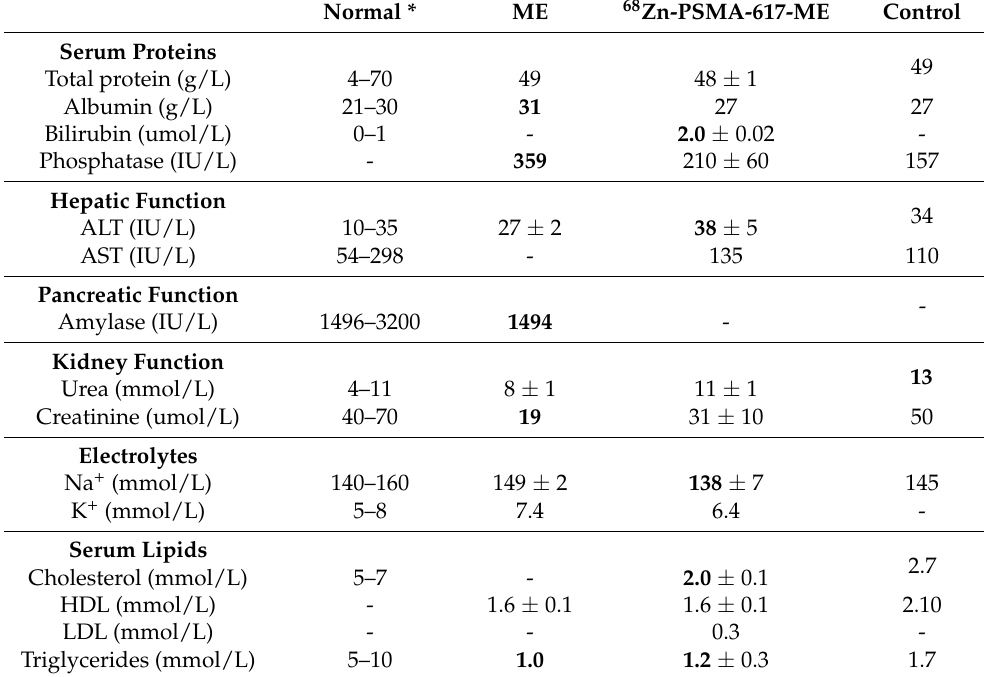
Table 3. Summary of clinical biochemistry (day 14 after compound injection).